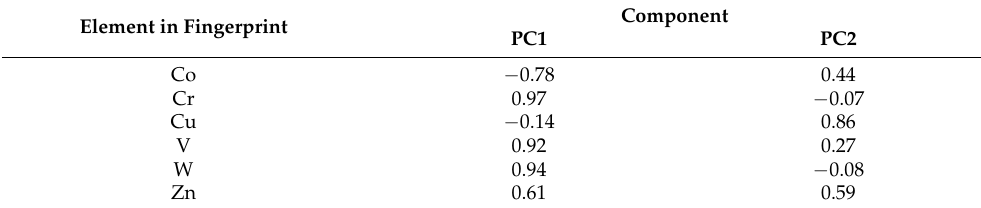
Table 2. Loadings on the first two principal components (PC1 and PC2). Element in